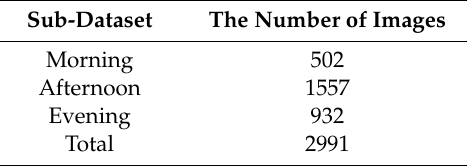
Table 5. Descriptions of